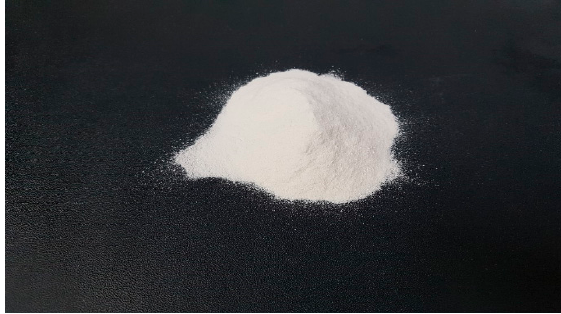
Figure 2. Used polymer powder.